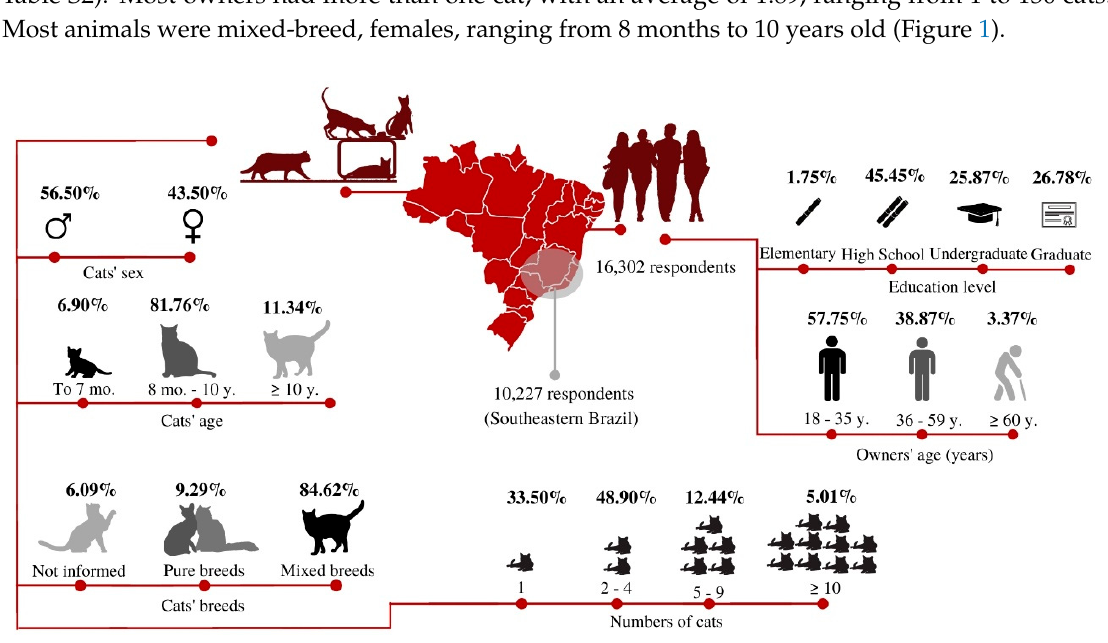
Figure 2. Plot of variables used in the principal component analysis for the type of management, cat